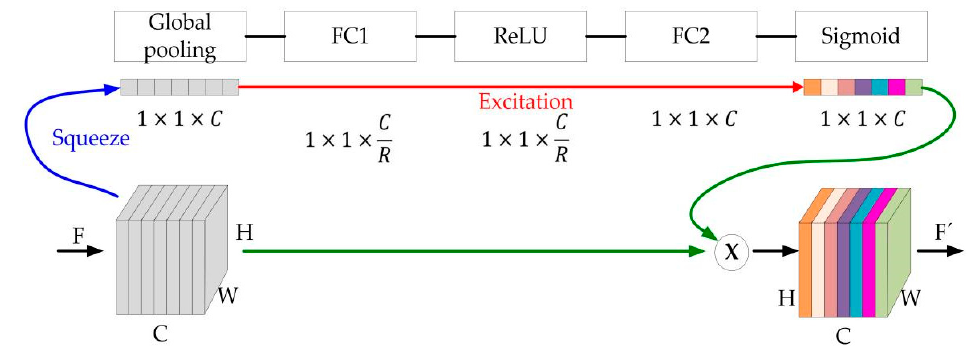
Figure 8. Structure of SENets attention module.